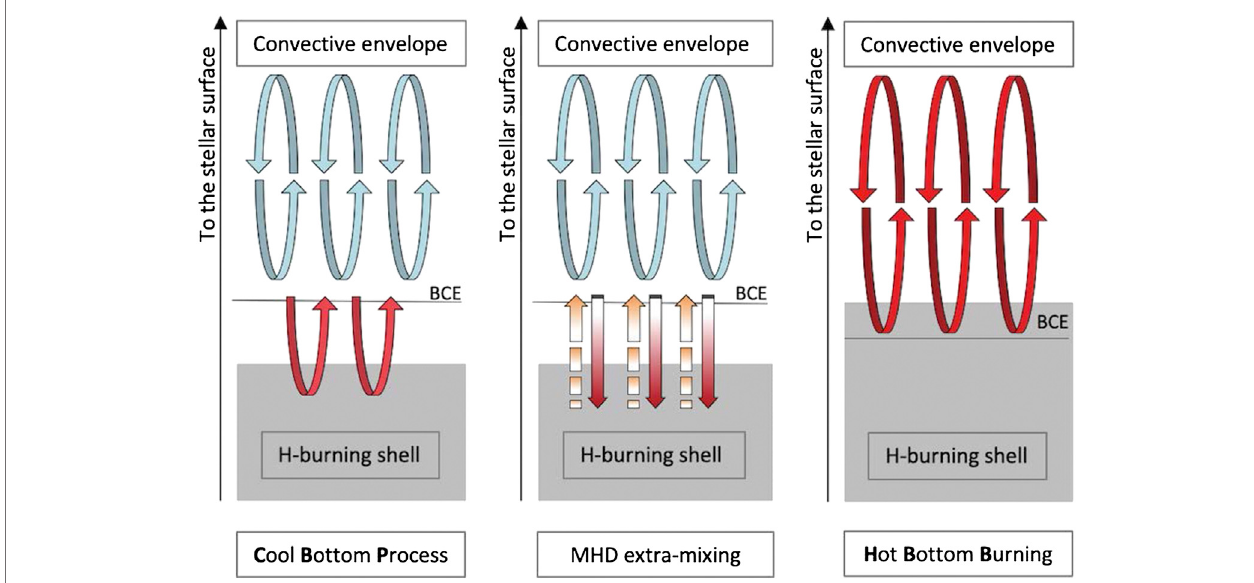
FIGURE2| Schemeofthemixingphenomenathatcoupledwiththestellarnucleosynthesismightaccountfortheoxygenandaluminumisotopicratiosrecordedin group 2oxide grains. Leftpanel: theclassic CBPoperated byaconveyor-belt-like mechanismthat startsfrom thebottom oftheconvectiveenvelope (BCE, asthought andpresentedbyWasserburgetal.,1995;Nollettetal.,2003). Centralpanel: themagneticinducedextra-mixing,thestellarmagnetic fi eldsinduceabottom-upmixing triggeredbytheup- fl owof “ bubbles ” accordingtoNucciandBusso(2014);Trippellaetal.(2016)andPalmerinietal.(2017). Rightpanel: theHBBthattakesplace whenthetemperatureabovetheBCEishighenoughtoallowthefurtheroccurrenceofsomeprotoncapturereactions.Thegrayareasinthethreepanelsshowthestellar region where temperatures are suf fi ciently high to burn H. Figures are not to scale.